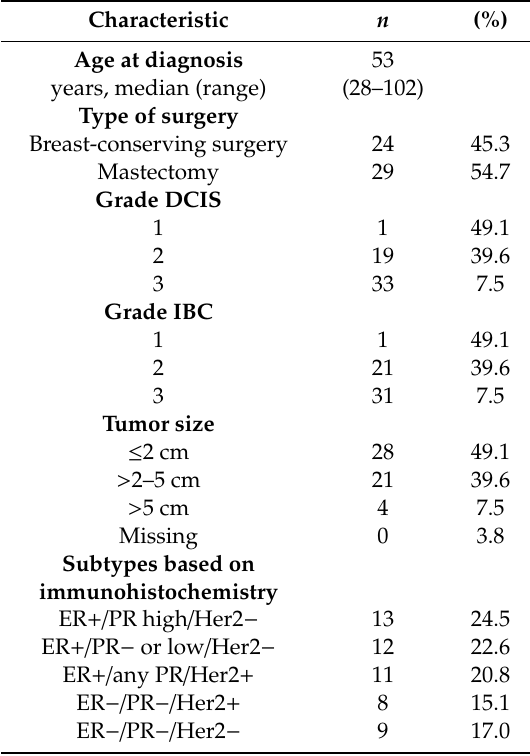
Table 1. Clinicopathological features of patients with ductal carcinoma in situ (DCIS) and adjacent invasive breast cancer (IBC) ( n =